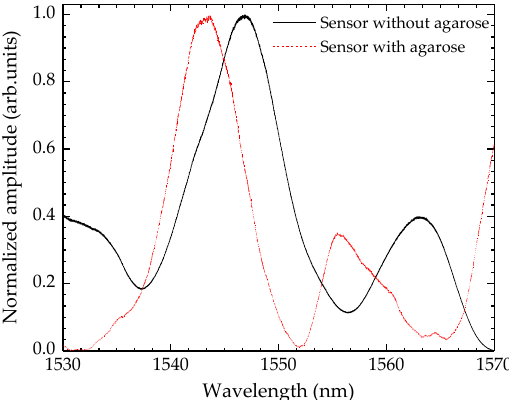
Figure 4. Sensors spectra before and after coating.